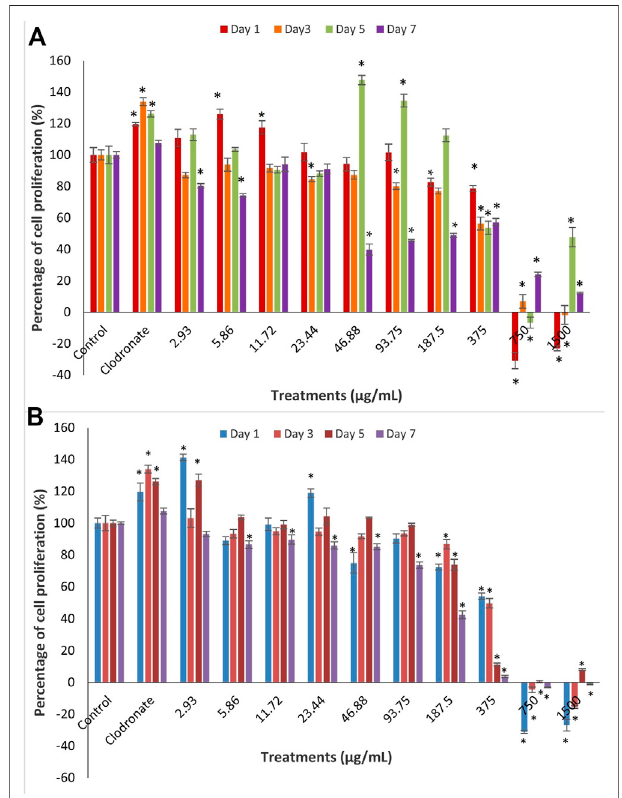
FIGURE 2 | Cell proliferation of MC3T3-E1 (osteoblast) cells after treatment with different concentrations of B. acmella (A) aqueous ( Ba A) and (B) ethanol ( Ba E) extracts at Day 1, Day 3, Day 5 and Day 7 of incubation. Results (optical densities) were calculated as the percentage of unexposed control cultures and represented by mean ± SEM. * p -value less than 0.05 ( p < 0.05) indicated signi fi cant difference when compared to untreated cells (control) ( n (cid:2) 6) at same incubation